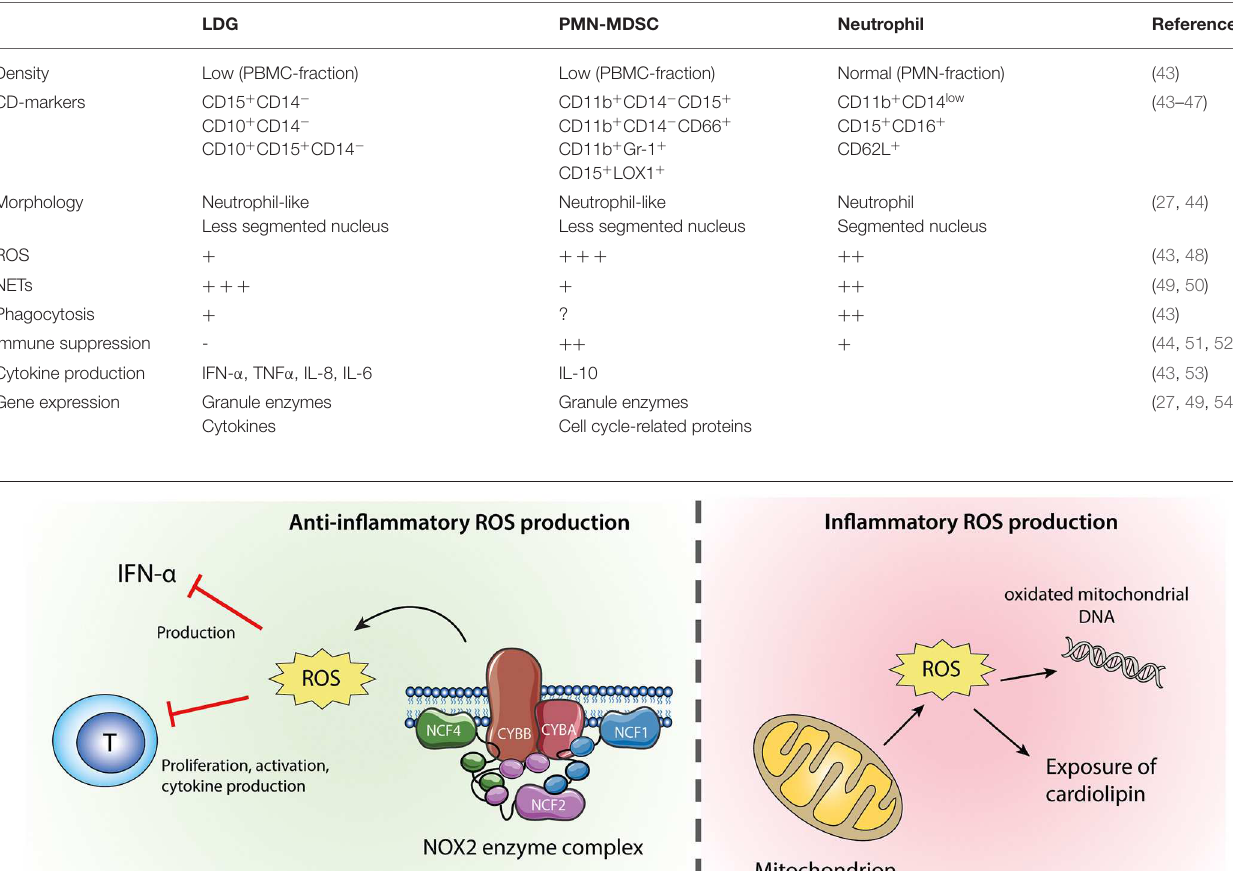
TABLE 1 | Phenotypes and functions of neutrophils, LDG and PMN-MDSC.